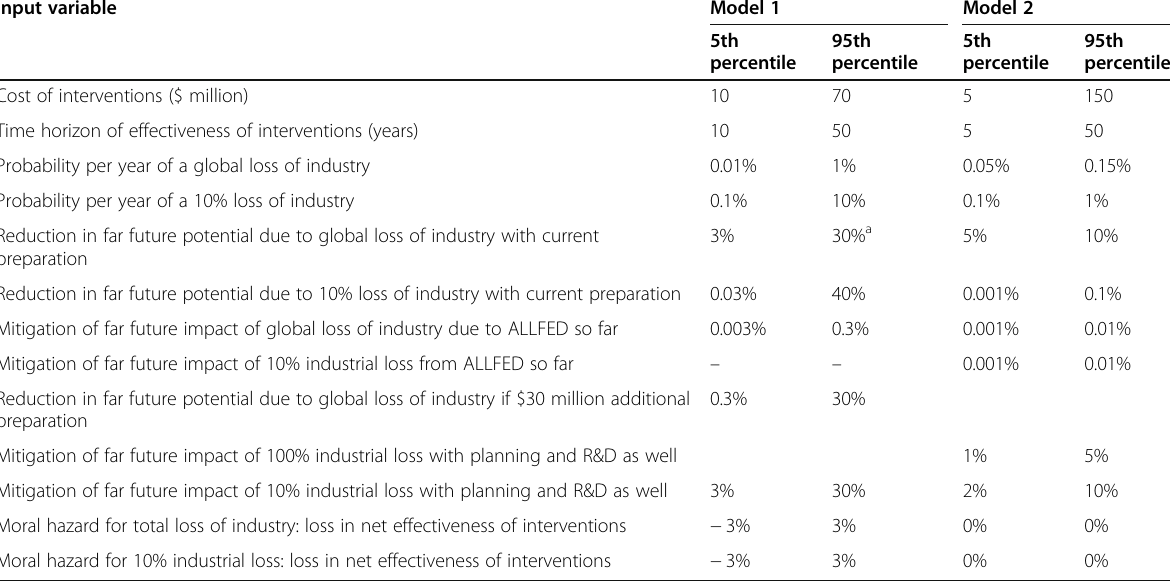
Table 1 Losing industry interventions input